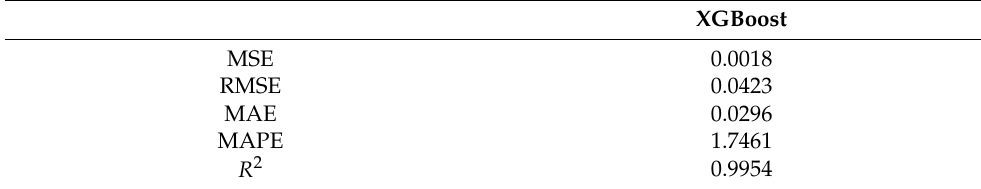
Table 5. XGBoost model evaluation results after Kwon